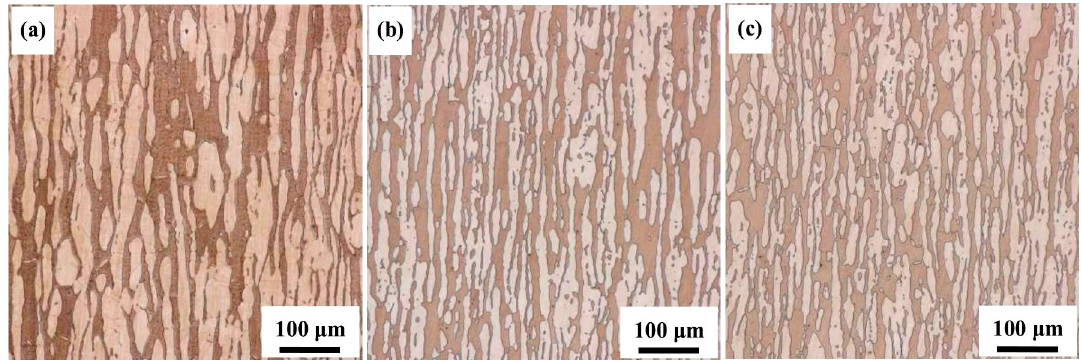
Figure 4. X-ray di ff ractions patterns of the 0#–2# experimental samples. Figure 4. X-ray diffractions patterns of the 0#–2# experimental samples. Figure 4. X-ray diffractions patterns of the 0#–2# experimental samples.